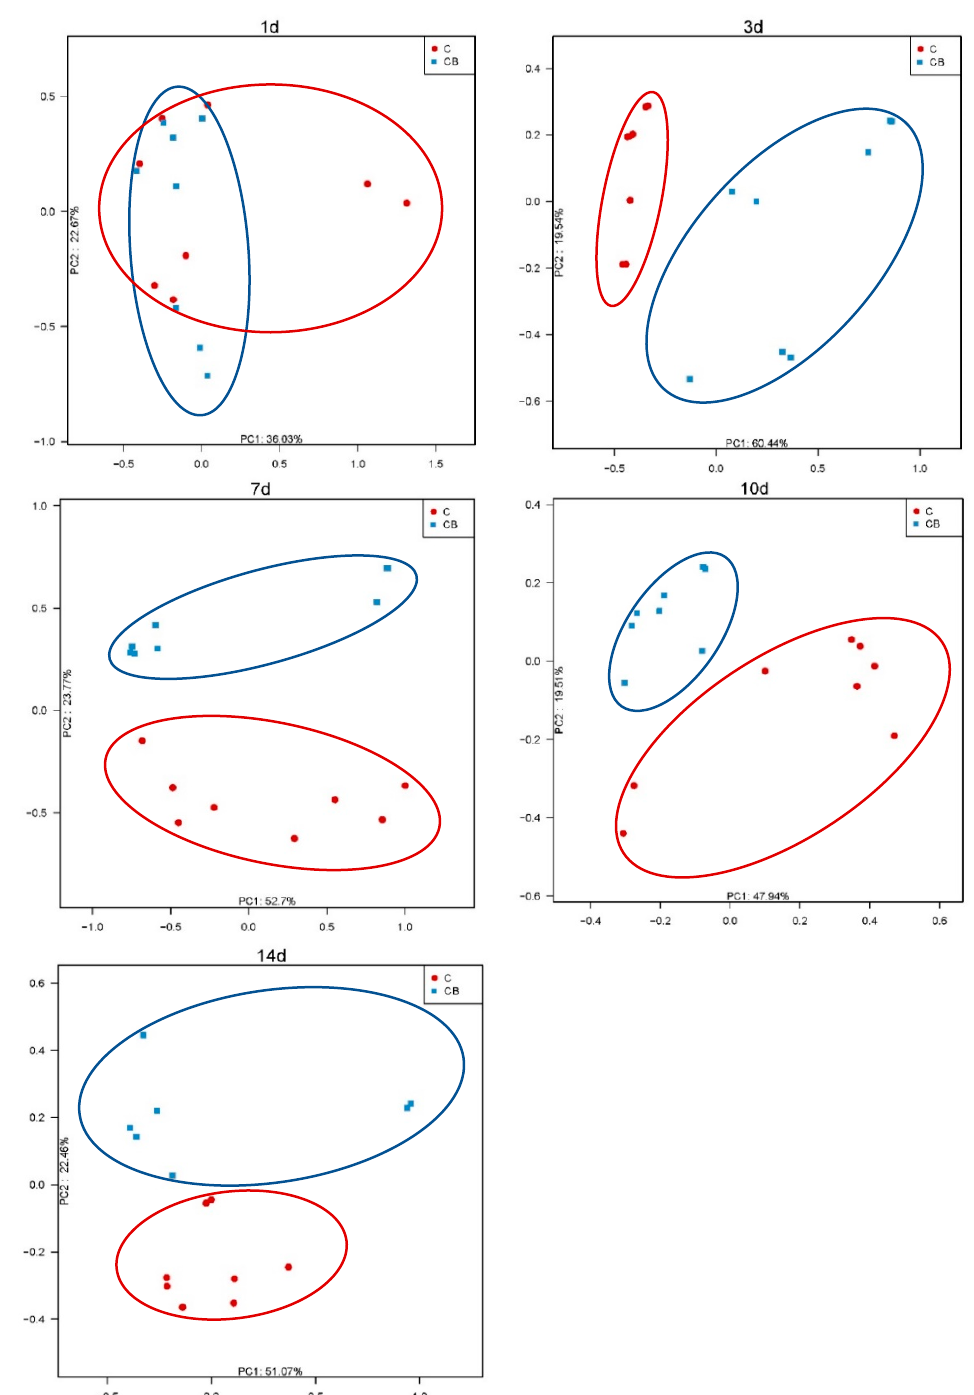
Figure 3. PCoA analysis of β diversity in the cecum bacterial communities of Muscovy ducks in the C and CB groups at the indicated ages. C, control group; CB, C. butyricum group. 1d, 3d, 7d, 10d, and 14d represent 1st day, 3rd day, 7th day, 10th day, and 14th day of the present experiment, respectively.